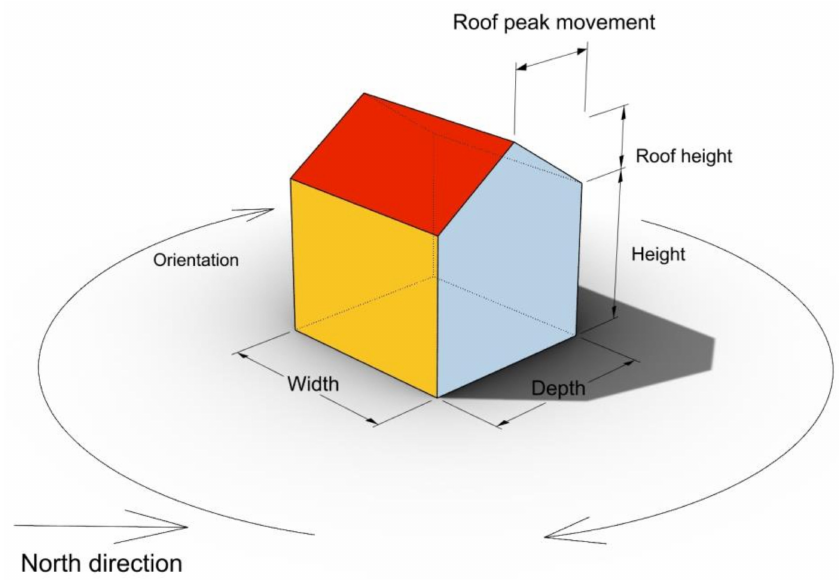
Figure 8. Variable parameters of the model building with constant volume of 1000 m 3 .